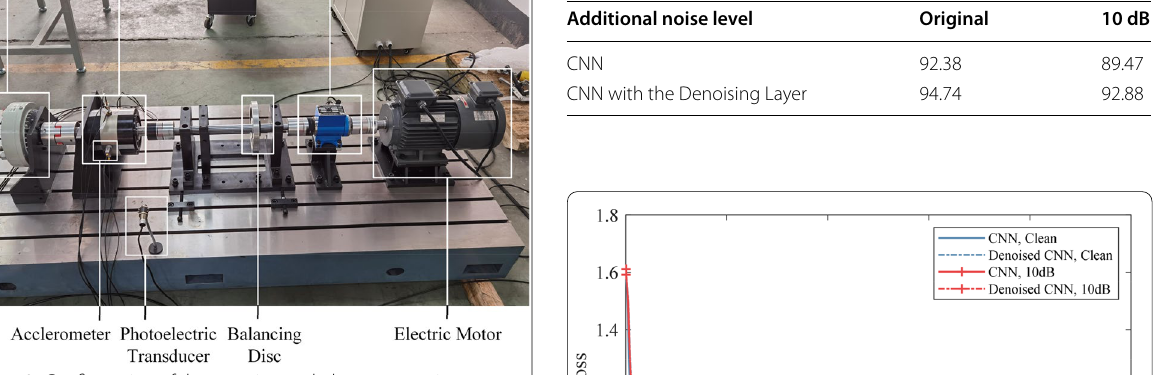
Figure 8 Configuration of the experimental planetary gearing system